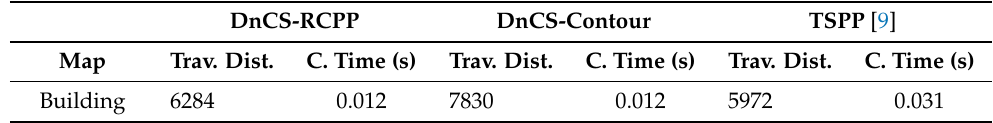
Table 2. Results for the case study. Travelling distance in